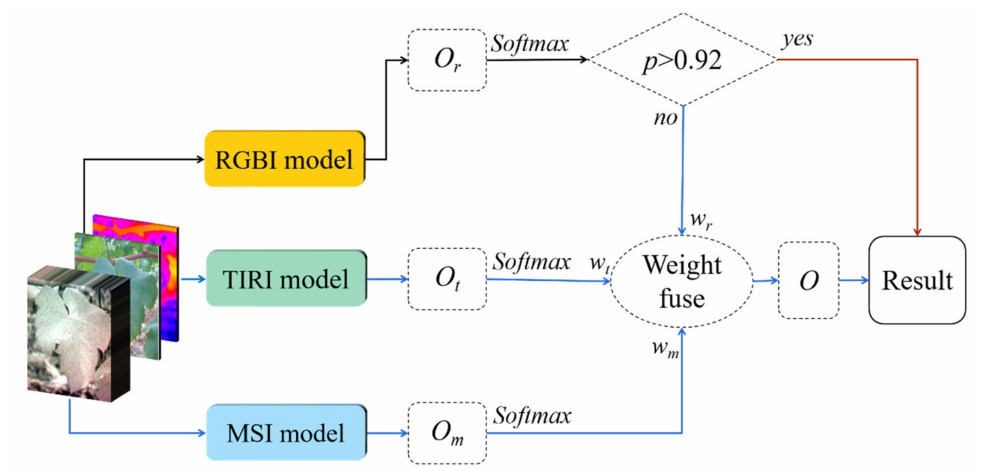
Figure 9. Data processing in the multi-source data fusion (MDF) model. The black line indicates that the RGBI model is used first when samples are detected. The red line represents that the final results can be directly detected by RGBI model when p > 0.92. The blue line represents the fusion decision-making by RGBI, MSI, and TIRI models when p ≤ 0.92.